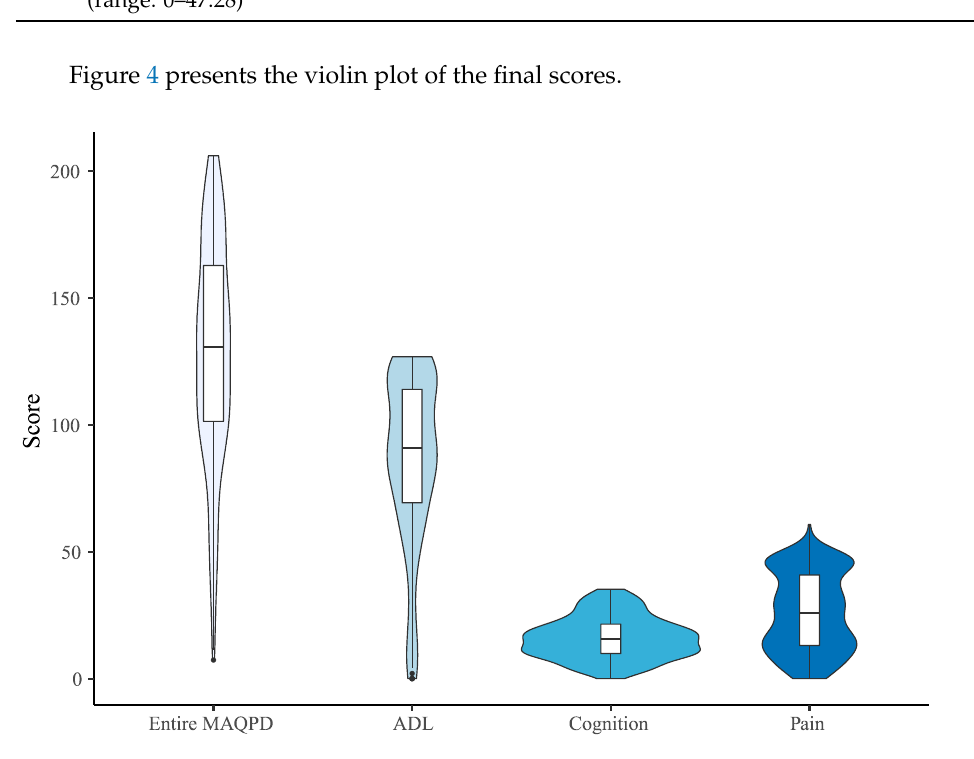
Table 3. Descriptive analysis of MAQPD scores.